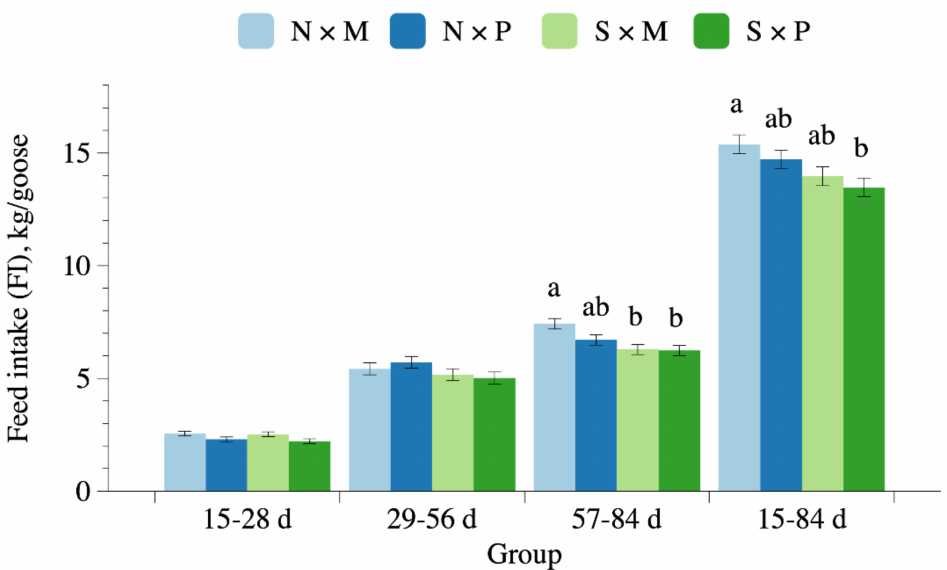
Figure 3. Feed intake in White Roman geese subjected to different floor types and pool conditions at different days of age. N × M: no swimming pool on the mud floor. N × P: no swimming pool on perforated plastic floor. S × M: swimming pool on the mud floor. S × P: swimming pool on perforated plastic floor. a,b Means with different superscripts within each group differ significantly ( p < 0.05).